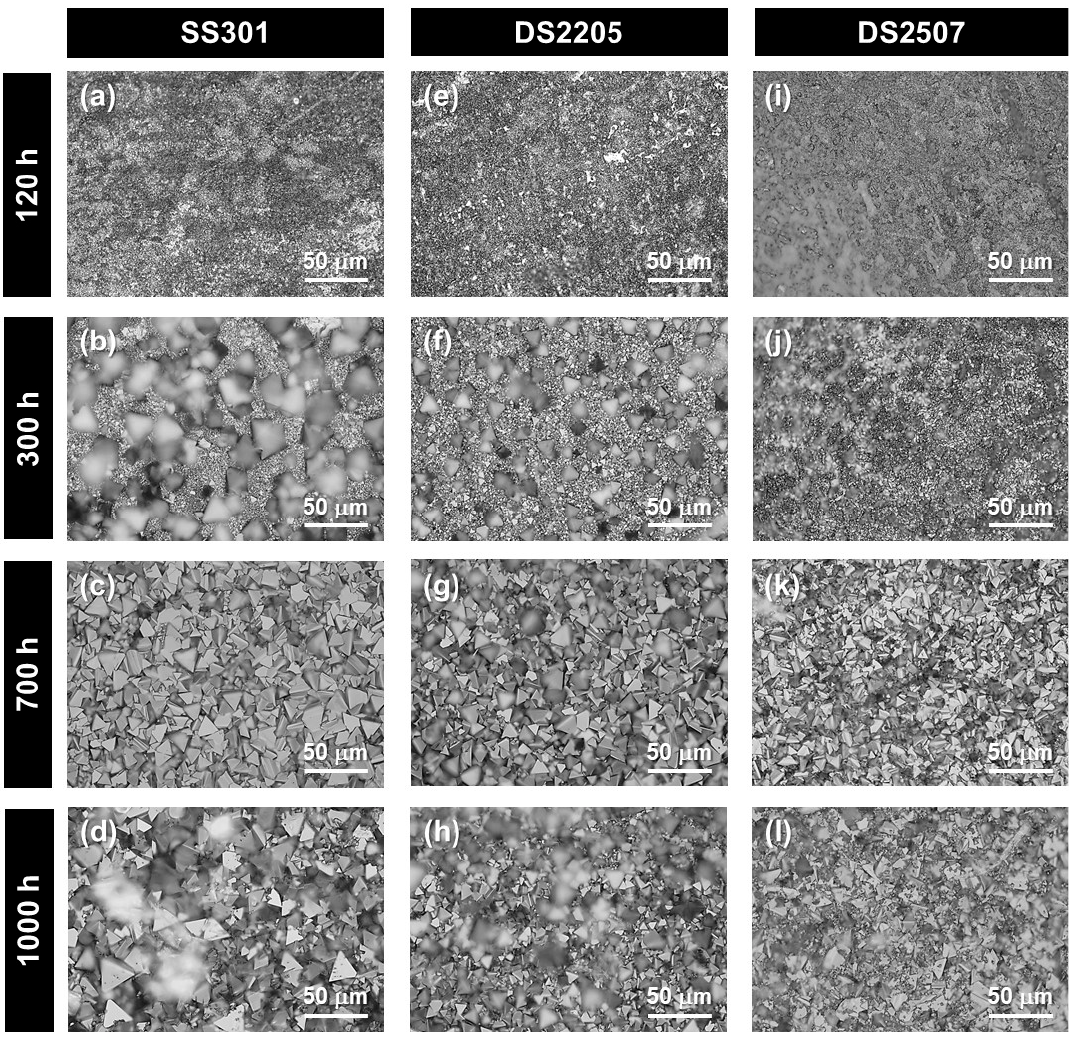
Figure 6. Surface images of the oxide scales, obtained from optical microscopy, formed on the ( a – d ) SS301, ( e – h ) DS2205 and ( i – l ) DS2507 after exposing to molten salts for different times.